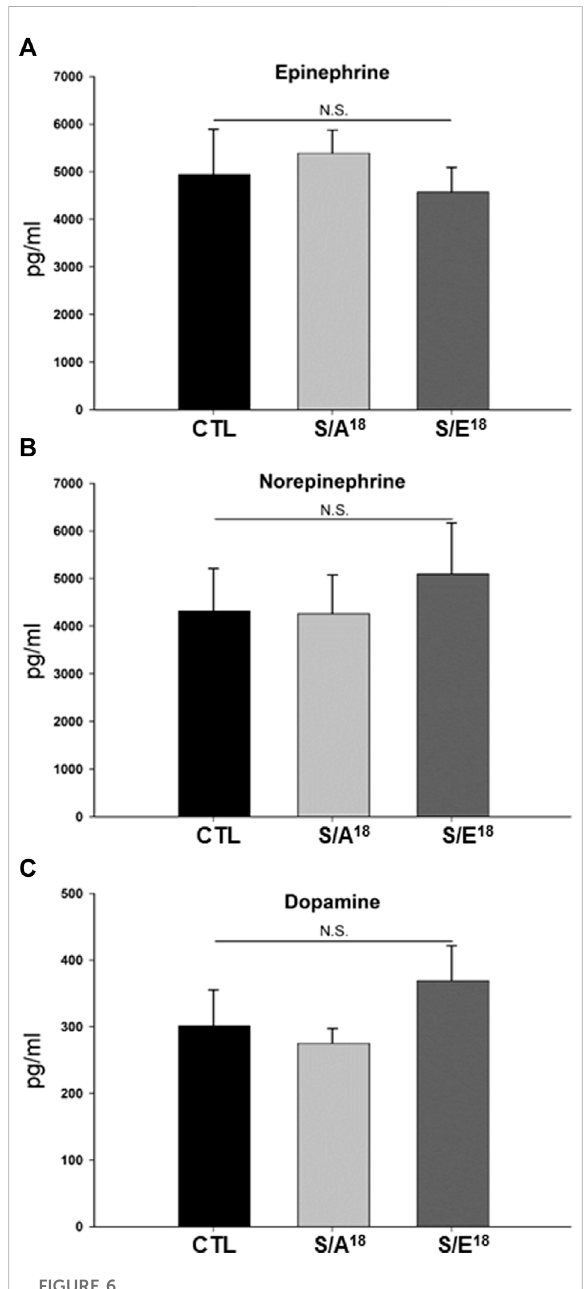
FIGURE 6 (A – C) Circulating levels of catecholamines in S/A 18 and S/E 18 peptide mice treated at 4.5 mg/kg/day dose for 2 weeks ( n =